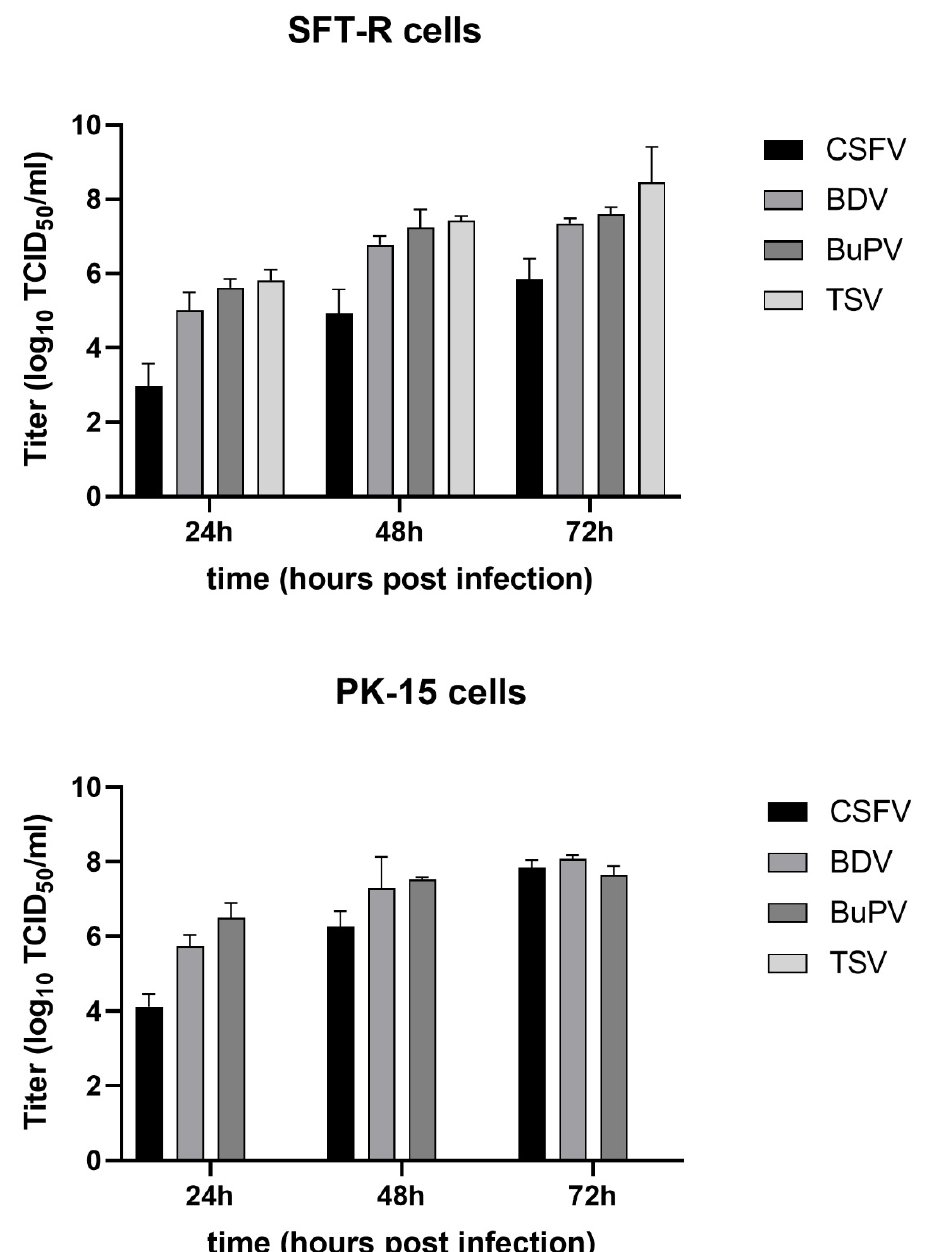
Figure 3. Kinetic of viral replication of Tunisian sheep-like virus (TSV isolate 70282/2007/EN), classical swine fever virus (CSFV strain Diepholz), border disease virus (BDV strain Frijters) and Bungowannah virus (BuPV) on ovine (SFT-R) and porcine (PK-15) cells. The cells were infected using a multiplicity of infection (MOI) of 0.1. Infectious titers were determined as 50% tissue culture infectious doses (TCID 50 ) per mL at the indicated time points post infection by endpoint dilution assay in quadruplicates from cell culture supernatants of three independent infection experiments. Mean values with standard deviations are shown.